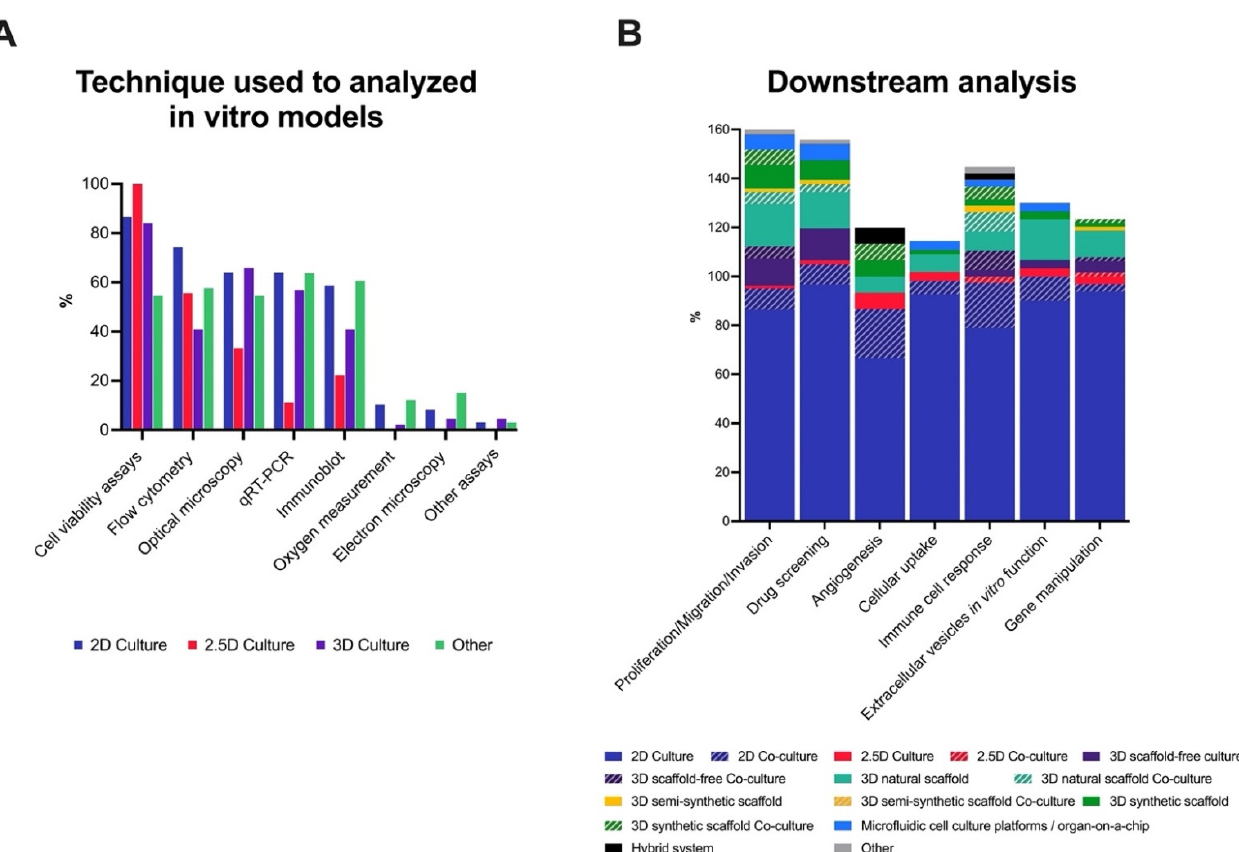
Figure 6. Analysis of pre-clinical in vitro model and their main applications. ( A ) Most used techniques to analyze in vitro models.; ( B ) Choice of cell culture models for application in the various downstream applications. Most commonly used in vitro models used for proliferation/migration/invasion assays, drug screening analysis, angiogenesis assay, cellular uptake/release assays, immune cell response assays, extracellular vesicles in vitro functional assay and gene manipulation assays. Bars represent the percentage for each option, with respondents being able to choose more than one option as appropriate. Percentages were calculated based on the reported use of each technique.